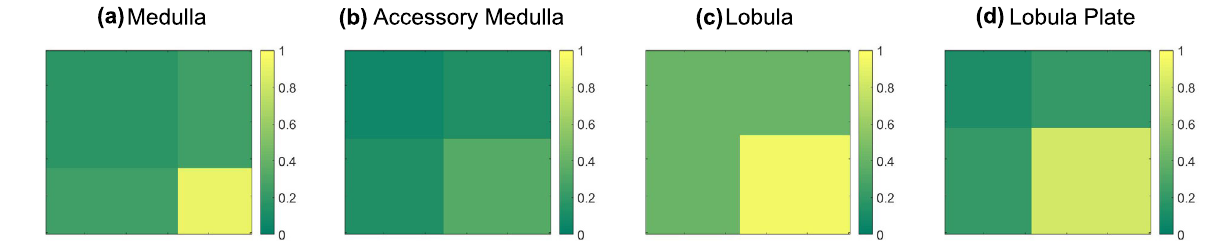
Fig. 7 Network generator inference for a Drosophila connectome in different regions of the optical lobe. The regions are a Medulla, b Accessory Medulla, c Lobula, and d Lobula Plate. The reconstructed initial models θ (1) are visualized as the squares. The inference results linking probability p (1) and node attribute probability l (1) are presented as color and side length of sub-blocks in the yellow-green squares. Yellower sub-block represents relatively larger linking probability. The reconstructed network generator models can be easily distinguished by comparing the color and side length of the sub-